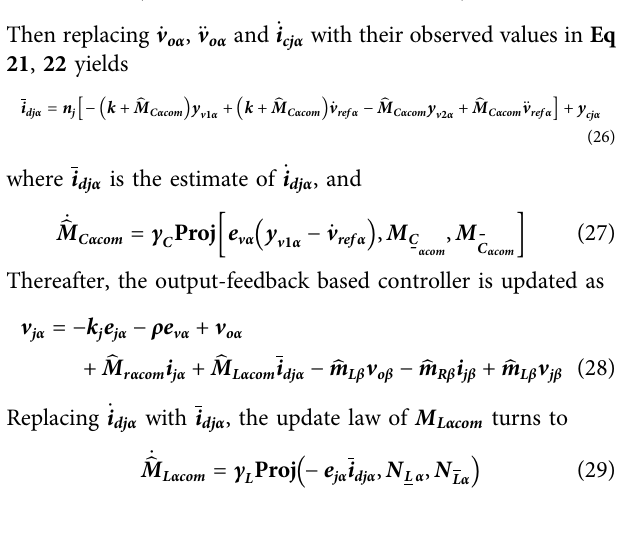
Frontiers in Energy Research |